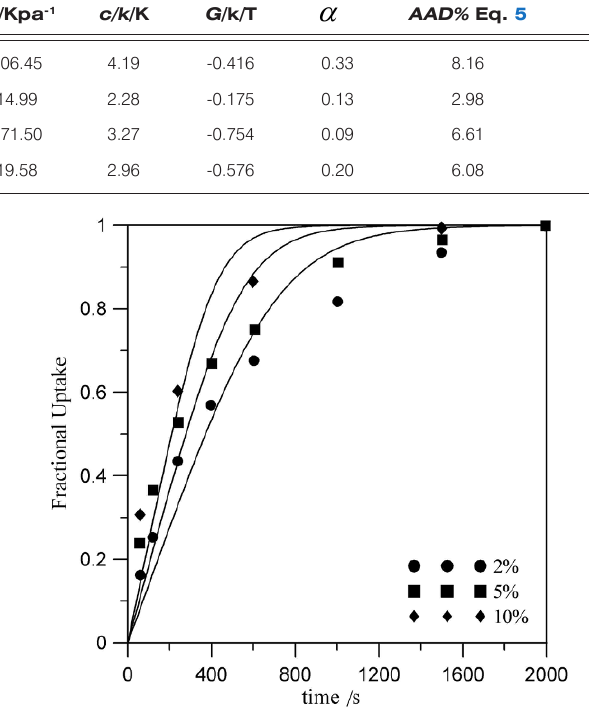
Table 3. Values of the parameters reported in [13] obtained by applying Eq. 5 to the experimental equilibrium isotherms of C zeolite NaX [19],